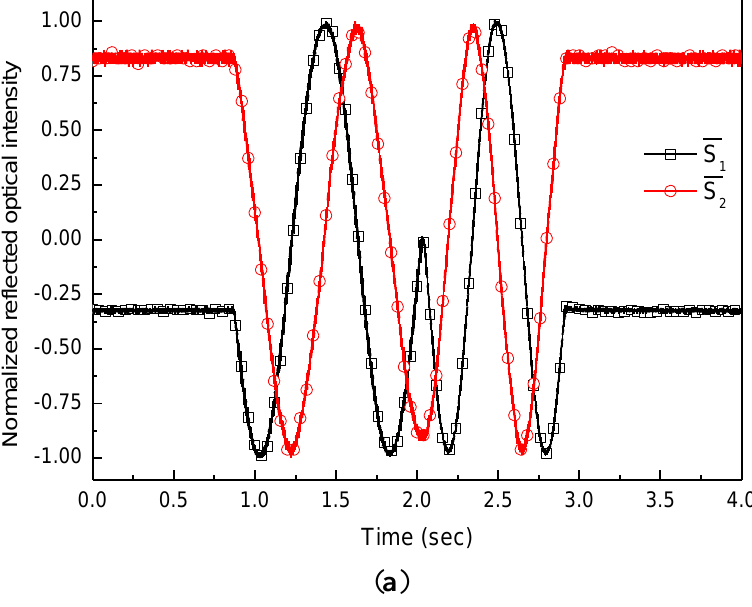
Figure 9. In-plane displacement measurement. ( a ) Normalized reflected signals of the two OFs in quadrature; ( b ) Comparisons of the in-plane displacement measurement by the proposed FOS and LDS (LK-H050); ( c ) Accuracy between the measured displacements by the proposed FOS and commercial